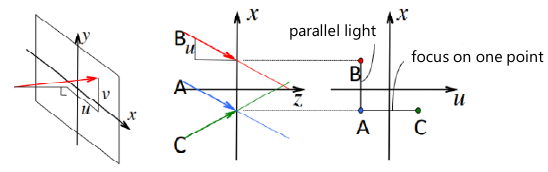
Figure 1. Representation of light field